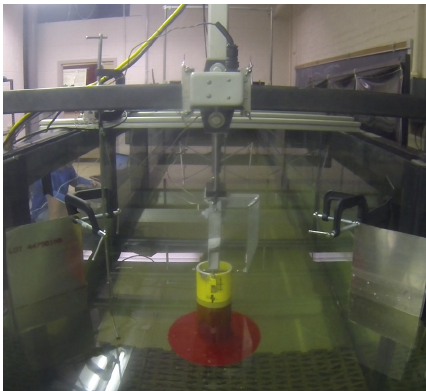
Figure 4. Photo showing the Marine Ocean and Offshore Research (MOOR) wave tank with the model and actuator in the foreground. Wave deflectors on either side for still water